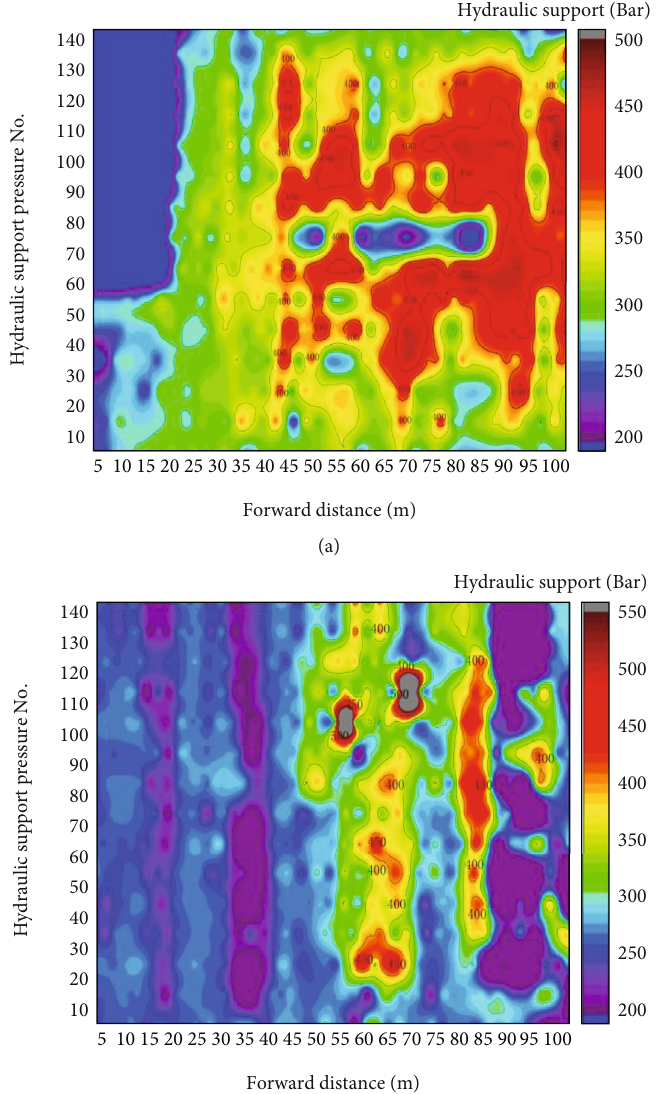
Figure 7: Comparison of the ore pressure law during initial production of the working face with and without hydraulic fracturing. (a) Mining pressure of 42106 working face during initial mining (no fracturing on the roof). (b) Mining pressure behavior of 42108 working face during initial mining (the roof has been